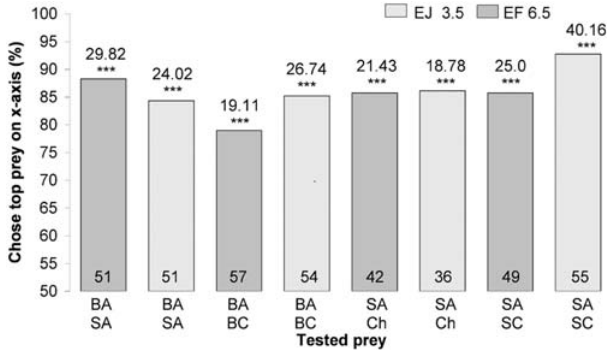
Figure 2. Simultaneous-presentation mount tests of sated Evarcha culicivora. Percentage: spiders that chose prey type at top list of two under bar. E= Evarcha culicivora . J=juvenile. F=adult female. BA=- blood-fed Anopheles . SA=sugar-fed Anopheles . Ch=chironomid midge. BC=blood-fed Culex . SC=sugar-fed Culex . Spider body length in mm. N inside each bar. Tests of goodness of fit: chi-square statistic above bar; null hypothesis, 50/50; *** P , 0.001.